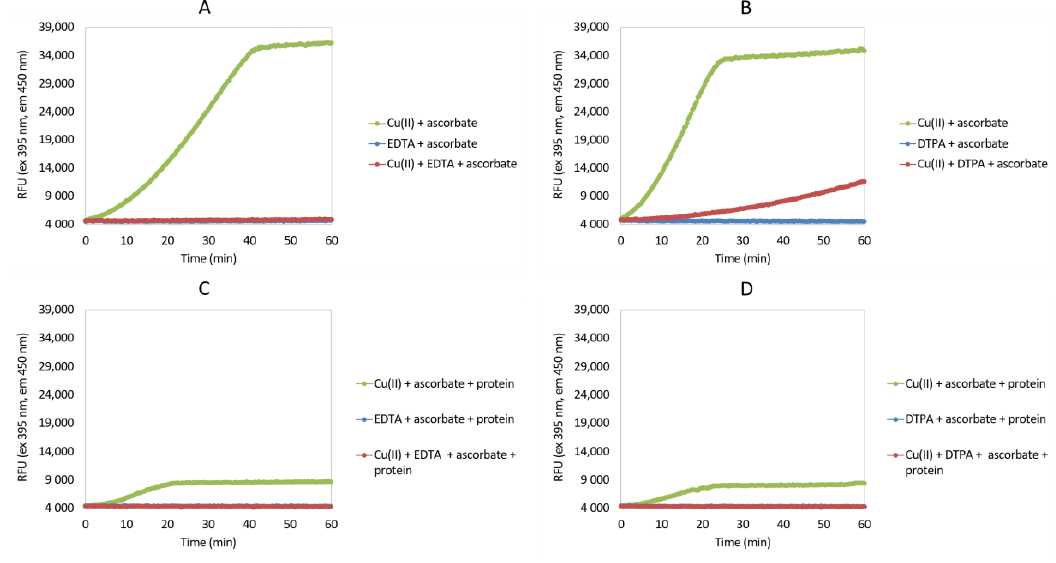
Figure Figure 3. Time courses of the production of • OH (RFU, relative fluorescence units) during autooxidation of Cu(II) complexes measured according to the fluorescence intensity of 7-hydroxy- coumarine-3-carboxylic acid after incubation of CCA with ascorbate ± Cu(II), and ± EDTA (A, C) or ± DTPA (B, D) , and plus protein (C, D) . Positive control, ascorbate plus Cu(II), and plus protein ( C, D ); negative control, ascorbate plus chelating agent (EDTA/DTPA) or antioxidant (quercetin/GSH), and plus protein ( C, D ); see also Figures S2 and S4. All solutions were prepared in 20 mM KH 2 PO 4 , 1 µM desferrioxamine, pH 7.4, except CuCl 2 (ultrapure water).